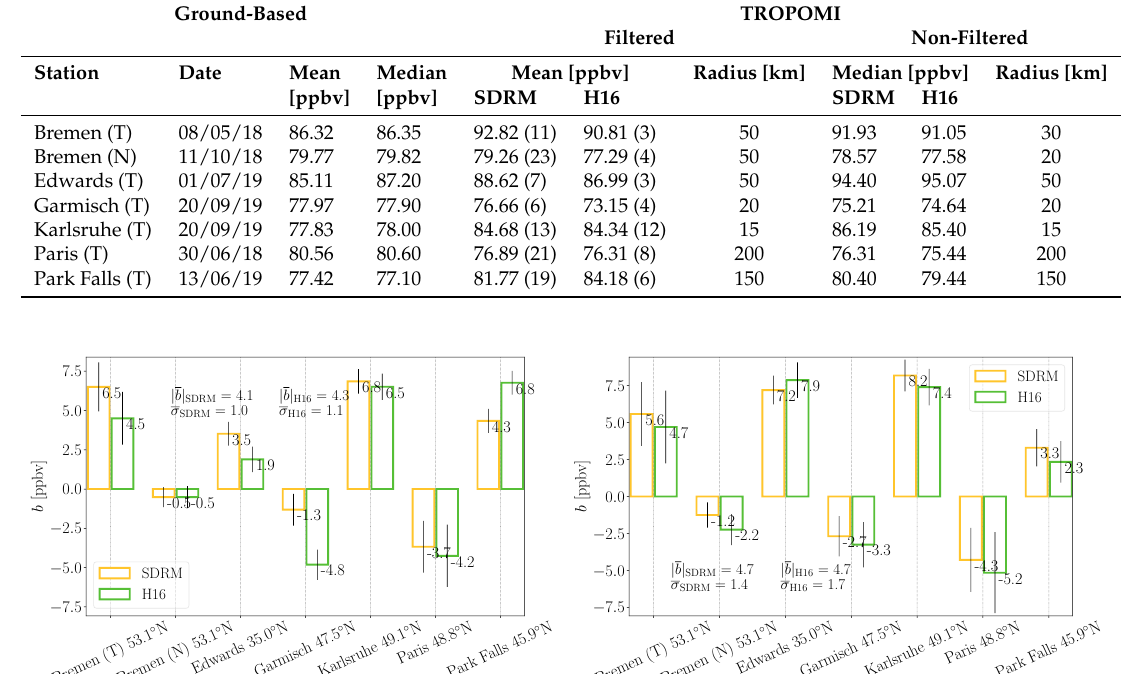
Table 2. Daily mean and median values for the SDRM- and H16-based CO mole fractions from TROPOMI measurements compared to Total Column Carbon Observing Network (TCCON) and Network for the Detection of Atmospheric Composition Change (NDACC) g-b observations. ‘Non-filtered’ specifies that only cloudy TROPOMI pixels were eliminated, while ‘Filtered’ additionally considers retrieval errors in the post-processing steps. ‘Radius’ designates the maximum distance for co-location, i.e., only TROPOMI observations from within that distance were compared to the g-b site. Values in brackets designate the number of observations after post-processing.